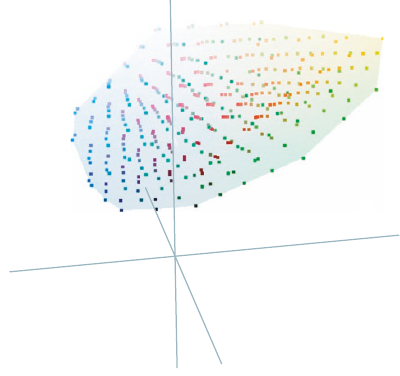
Figure 3: The 424 OSA-UCS samples represented in the CIELAB